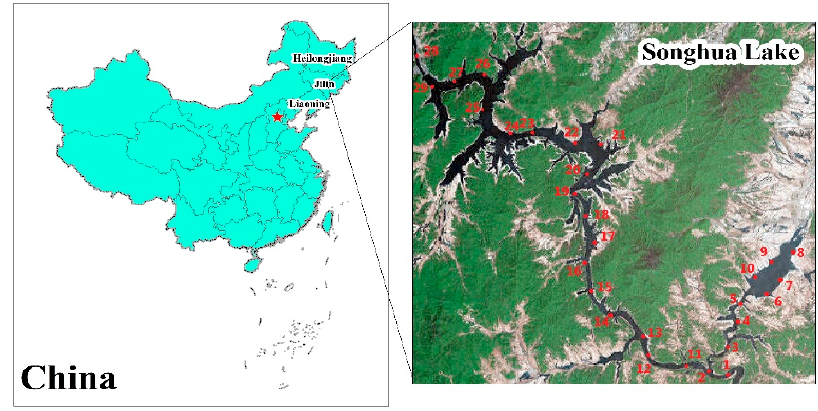
Figure 1. The locations of National Scenic Areas Songhuahu (NSAS) and sampling